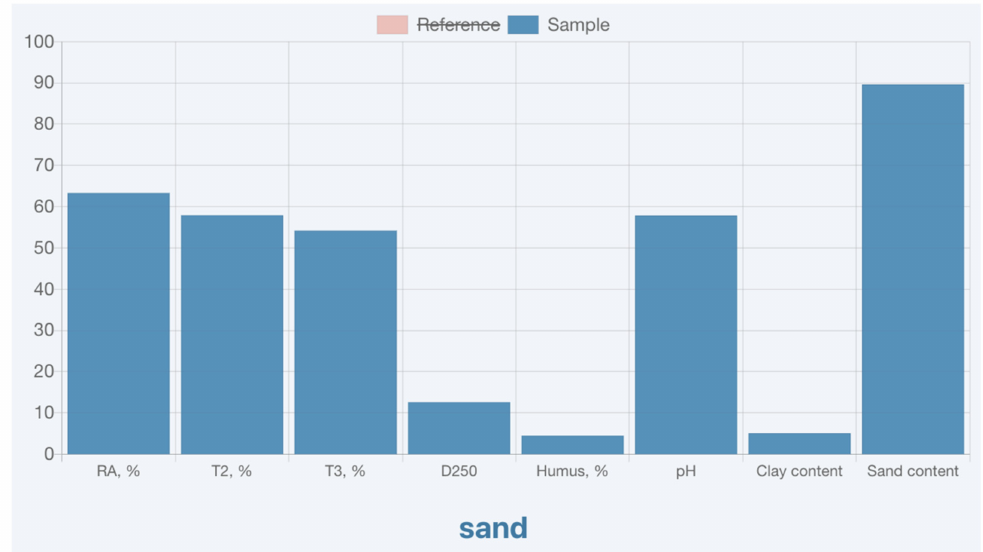
Figure 4. Application graph, the “reference” category is not active (crossed out) and the data is only displayed for